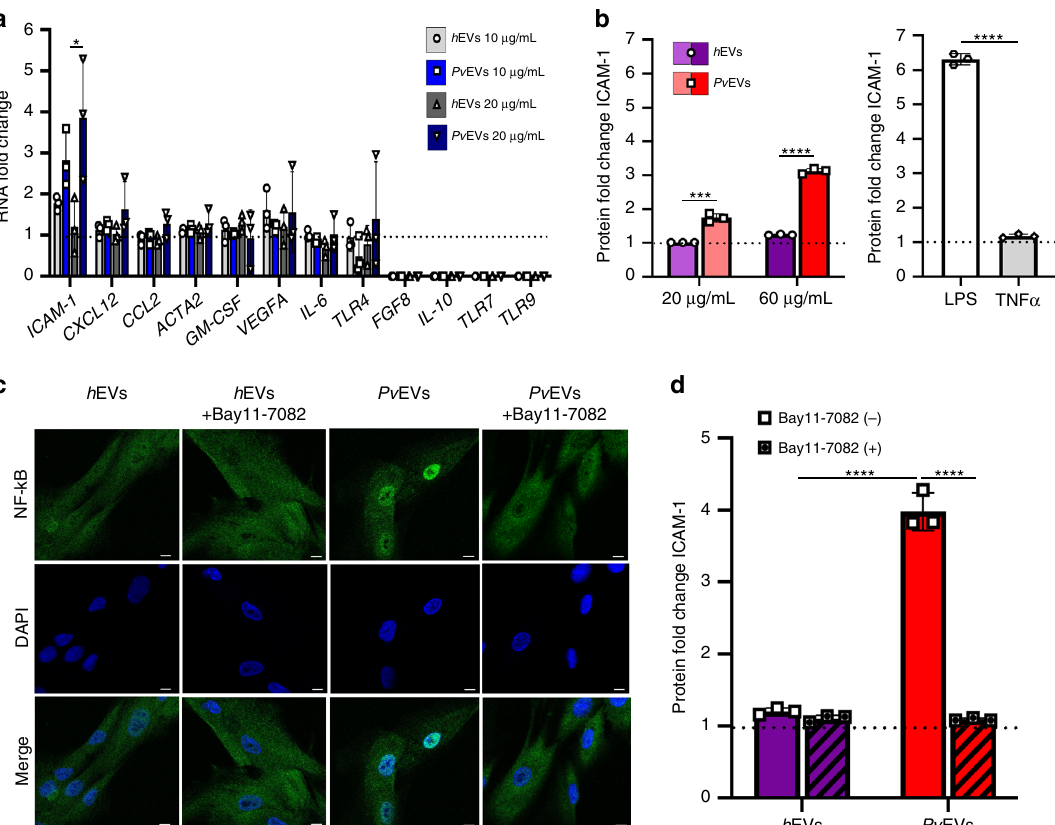
Fig. 3 ICAM-1 expression and NF-kB nuclear translocation in h SFs cells. a RNA expression. h SFs were incubated with media alone (Ctr) or with pooled h EVs or Pv EVs for 24 h. Quantitative RT-PCR was performed to analyse the expression of selected genes ( intercellular adhesion molecule 1 ( ICAM-1 ),